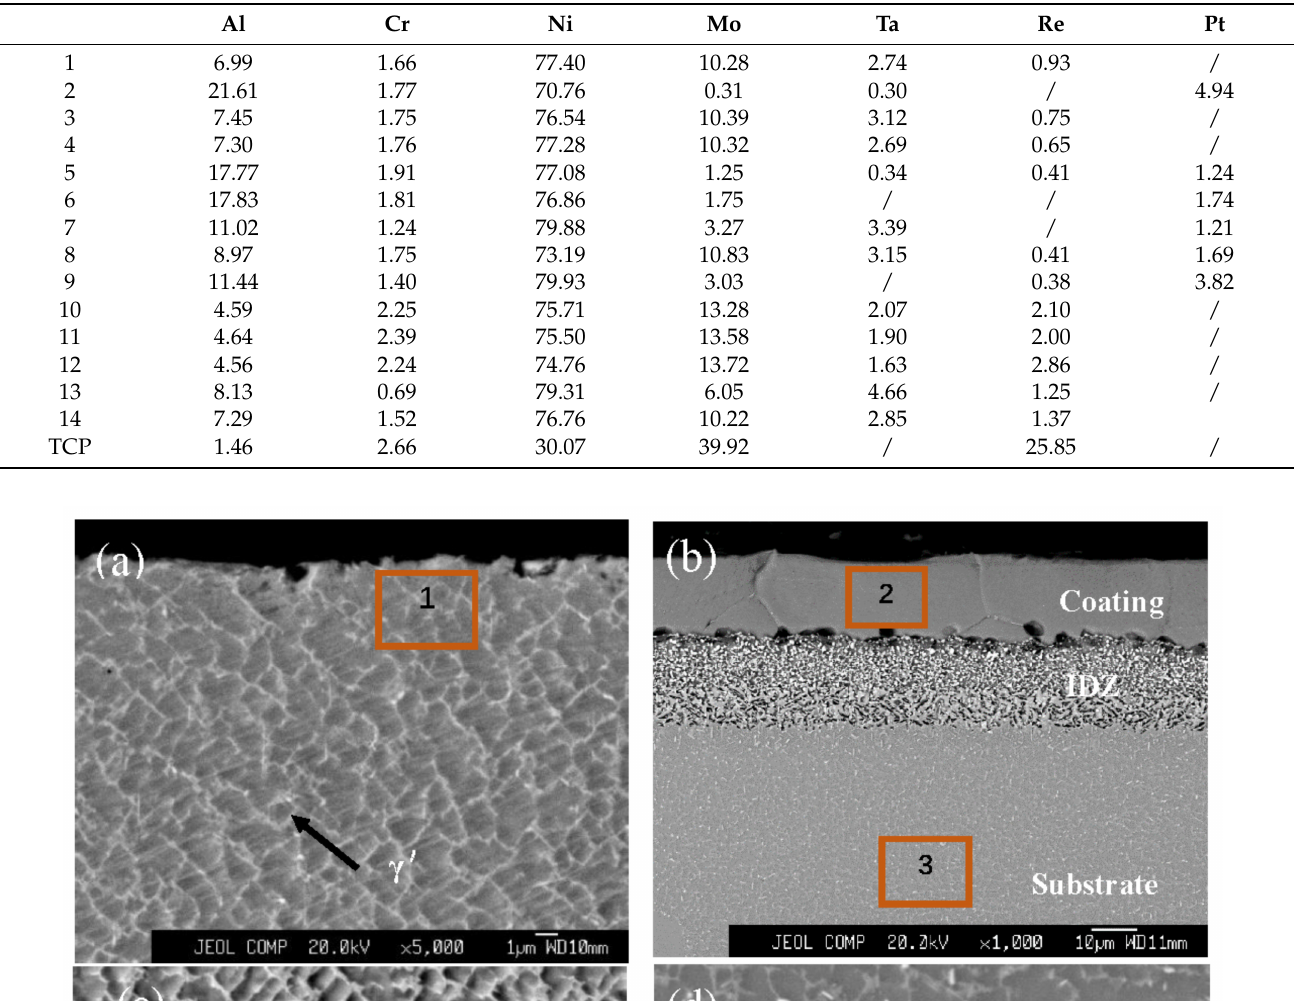
Table 1. Chemical compositions of the marked areas in Figures 2 and 3 (wt. %) by EDS.